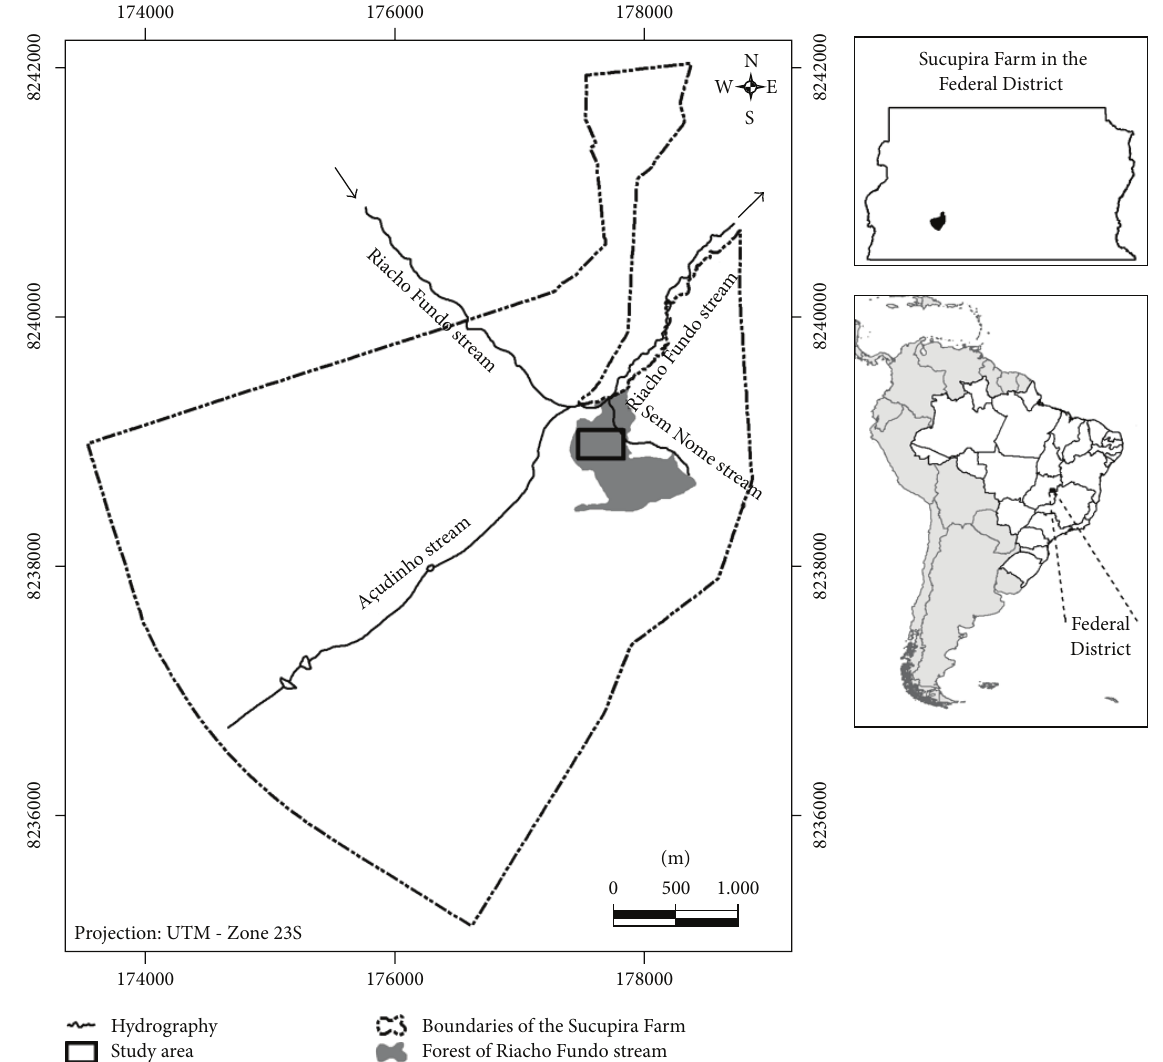
Figure 1: Location of the study area (Riacho Fundo forest) in Sucupira Farm, Federal District,